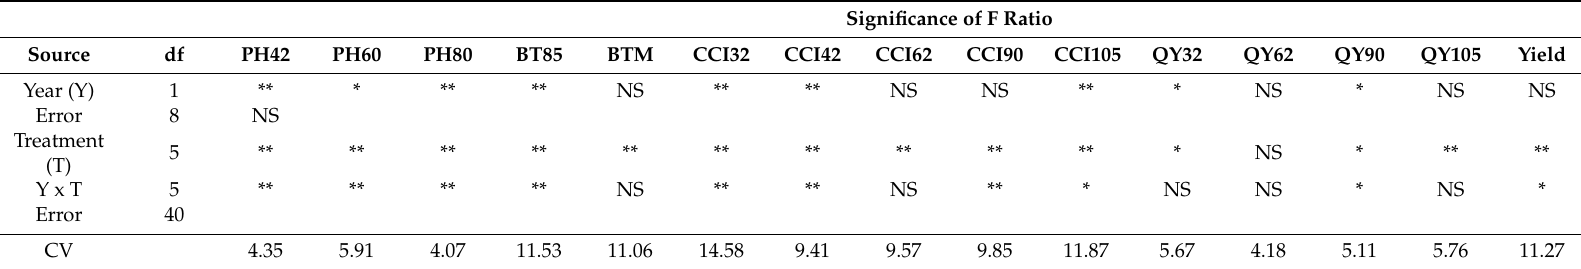
Table 4. Analysis of variance (one factor randomized complete block design combined over years) of the agronomic and physiological traits as influenced by the compost treatments.